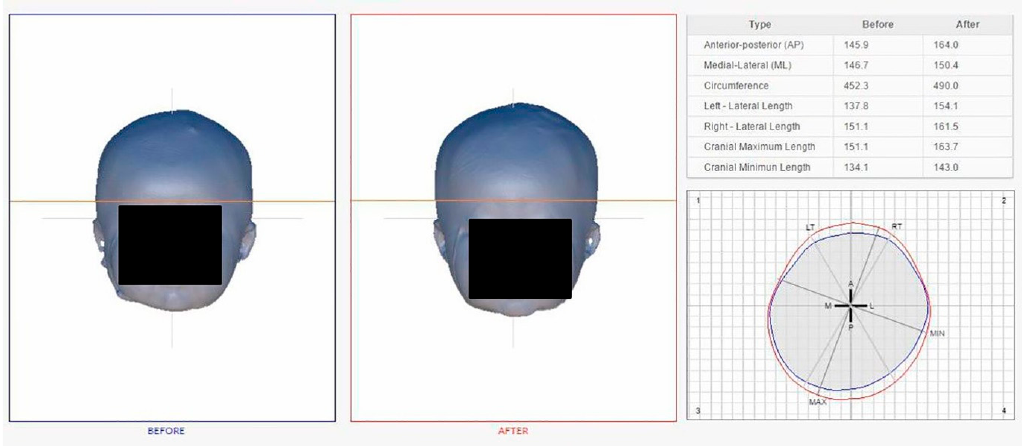
Figure 3. Software-assisted comparison of the head shape values before and after treatment. Cephalometric variables were measured by dividing by head into ten segments from the top of the head to the chin. The measurements were conducted monthly, and the helmet was adjusted accordingly.